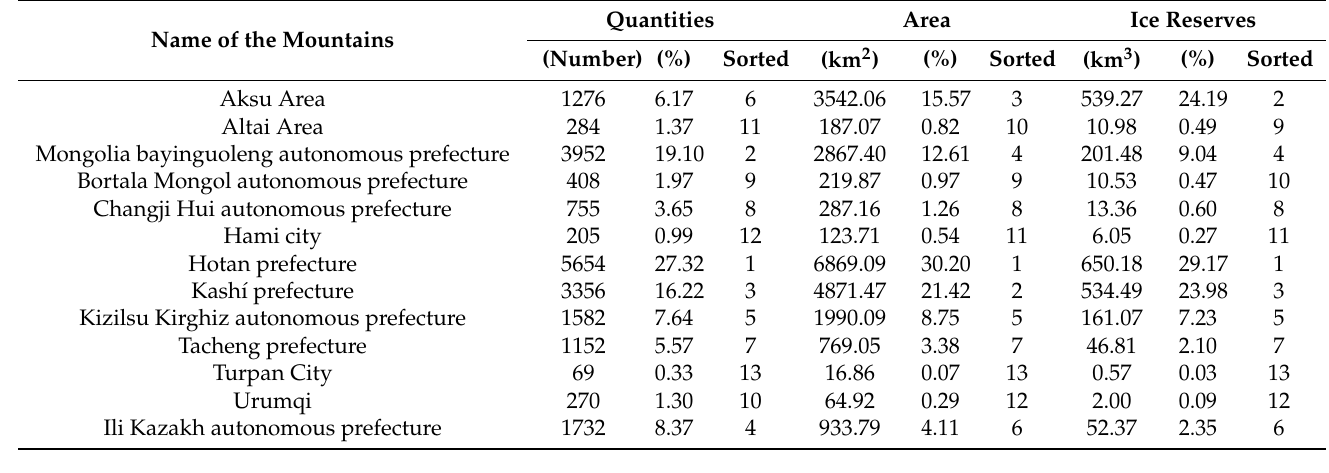
Table 4. The glacier resources in different mountains in Xinjiang.